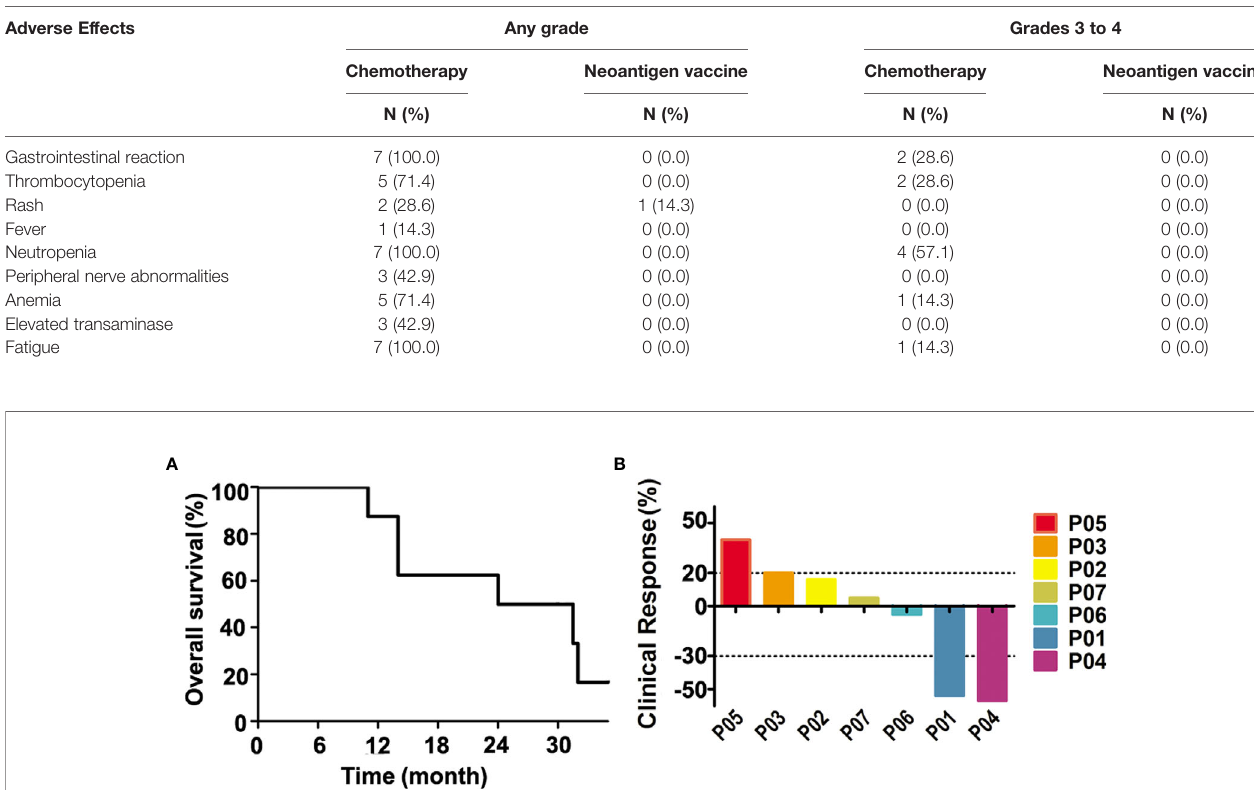
TABLE 2 | Comparison of adverse reactions between peptide therapy and chemotherapy in treated patients.